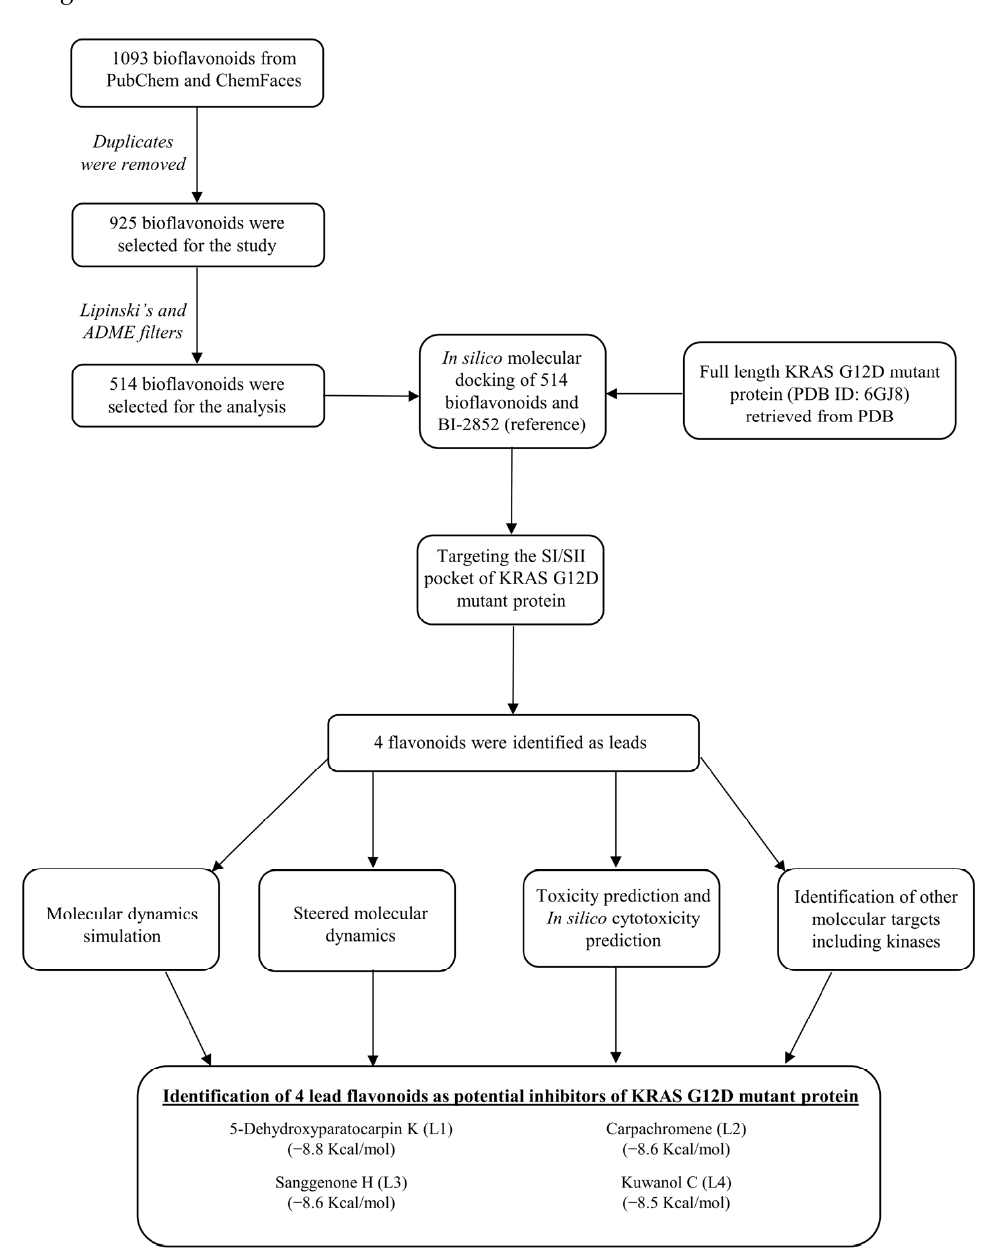
Figure 3. Schematic representation of the